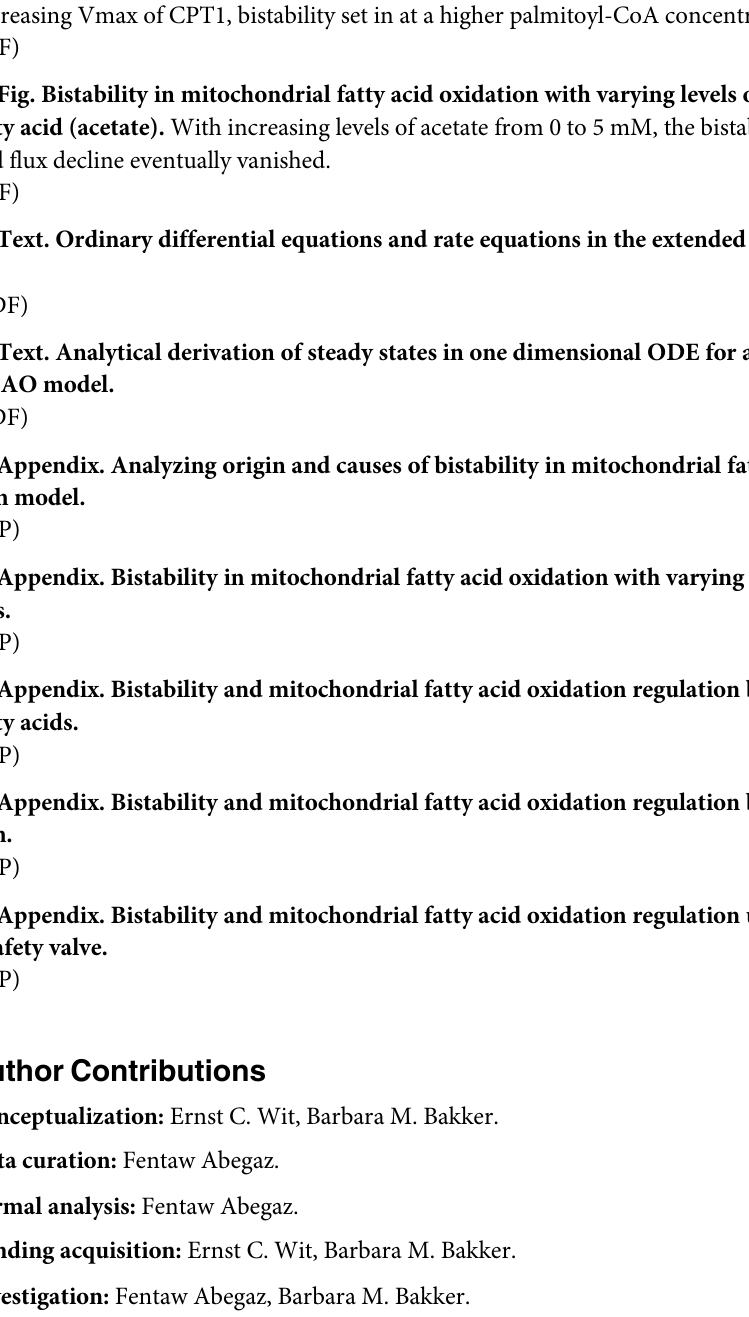
S7 Fig. Bistability in mitochondrial fatty acid oxidation with varying total pool of NAD + and NADH between 100 and 300 μ M and fixed NAD+:NADH at 20. (TIF) S8 Fig. Bistability in mitochondrial fatty acid oxidation with varying Vmax of CPT1. With decreasing Vmax of CPT1, bistability set in at a higher palmitoyl-CoA concentration. (TIF) S9 Fig. Bistability in mitochondrial fatty acid oxidation with varying levels of short chain fatty acid (acetate). With increasing levels of acetate from 0 to 5 mM, the bistability behavior and flux decline eventually